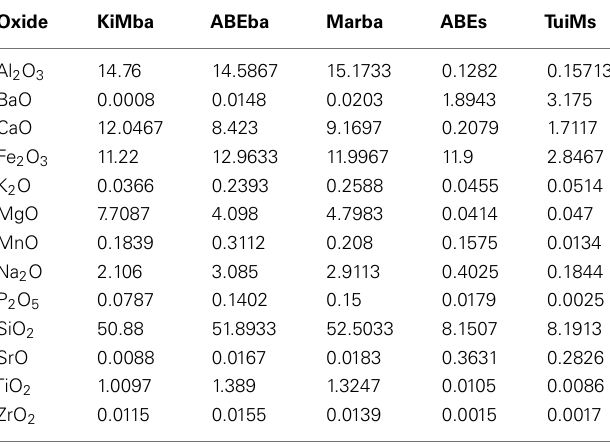
Table 2 | Major oxide composition of the rocks